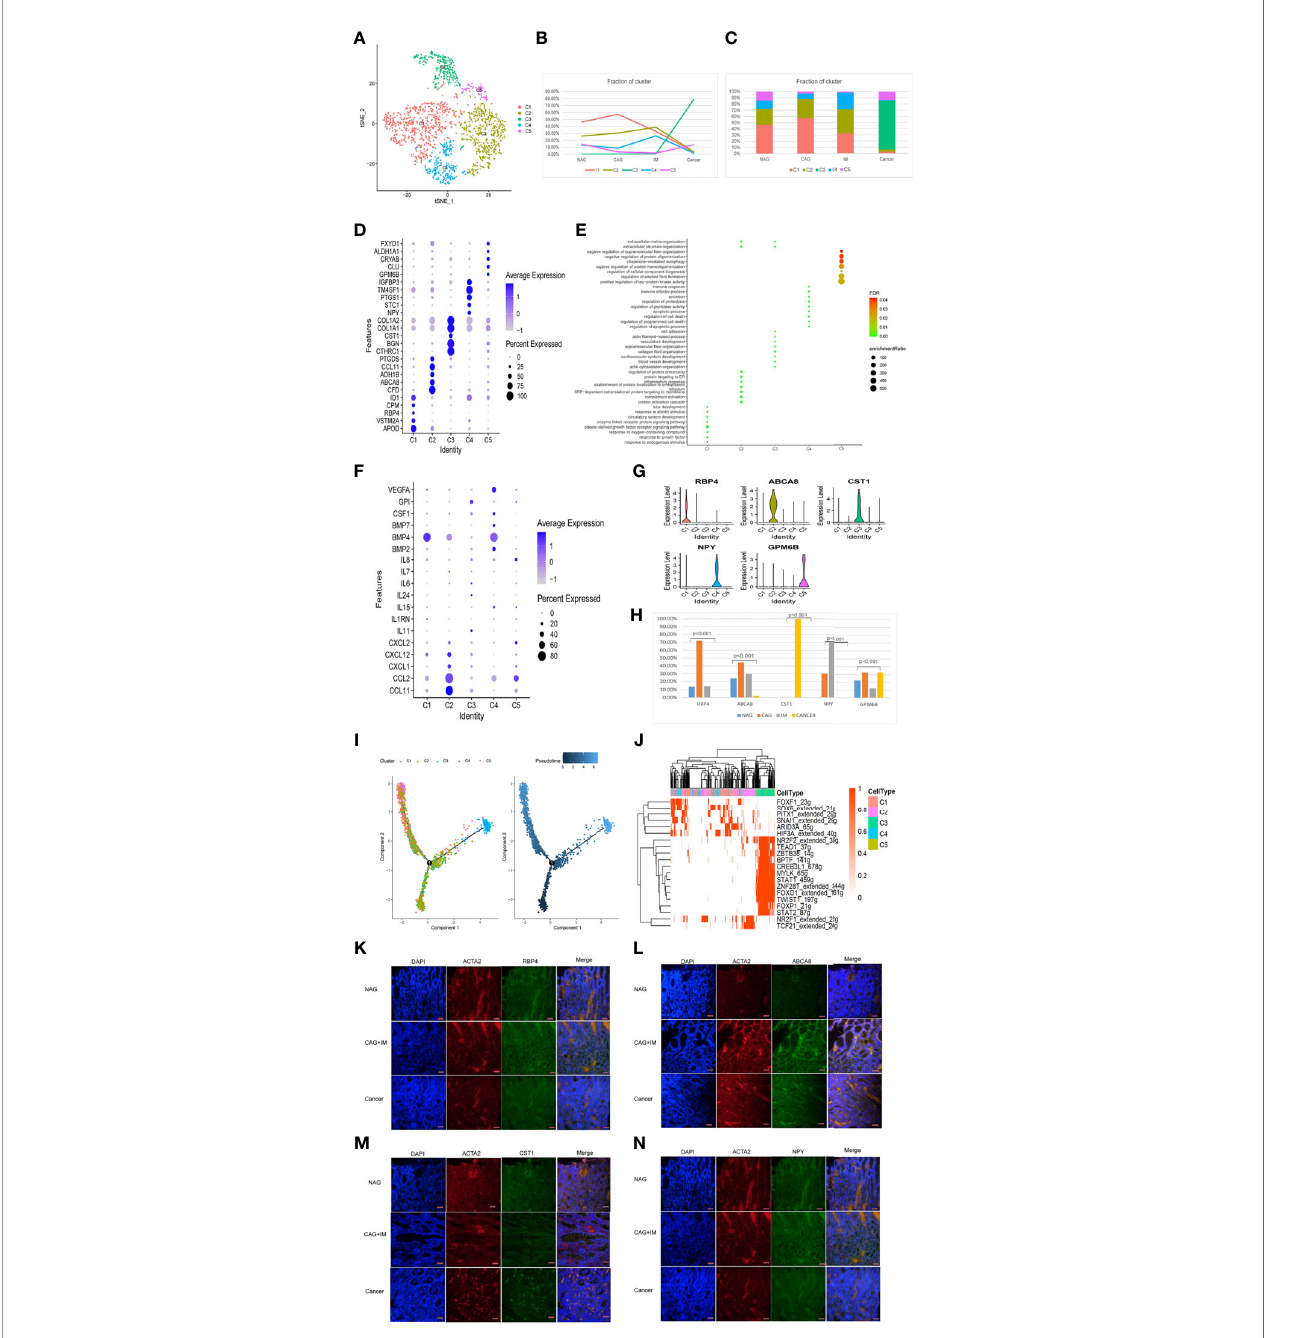
FIGURE 6 | Identi fi cation of fi broblast clusters and expression features at different stages. (A) tSNE plot of fi ve fi broblast cell subclusters. (B) Line chart displaying changing trend of the proportion of the fi ve cell types across the four stages. (C) Stacked histogram showing fi broblast composition across the four stages. (D) Bubble plot of the top fi ve markers of each cell cluster; dot sizes represent abundance while colors represent expression levels. (E) Bubble plot showing the biological functions of different cell clusters using GO; dot sizes represent abundance while colors represent q values. (G) Violin plots of marker genes in the fi ve subclusters. (F) Bubble plot showing scale normalized expression of representative genes involved in chemokine, cytokine, and growth factor processes. (H) Histograms of scale normalized expression levels of three marker genes at each stage. (I) Fibroblast cell differentiation trajectory with each color coded for pseudotime (right) and clusters (left). (J) AUC scores of transcription factor expression regulation using SCENIC. Results converted to binary data were visualized as heatmap plots constructed using the pheatmap function of R. (K) Immuno fl uorescence staining of RBP4 (green) and ACTA2 (red) in different stages of stomach disease. Scale bars, 50 m m. (L) Immuno fl uorescence staining of ABCA8 (green) and ACTA2 (red) in different stages of stomach disease. Scale bars, 50 m m. (M) Immuno fl uorescence staining of CST1 (green) and ACTA2 (red) in different stages of stomach disease. Scale bars, 50 m m. (N) Immuno fl uorescence staining of NPY (green) and ACTA2 (red) in different stages of stomach disease. Scale bars, 50 m